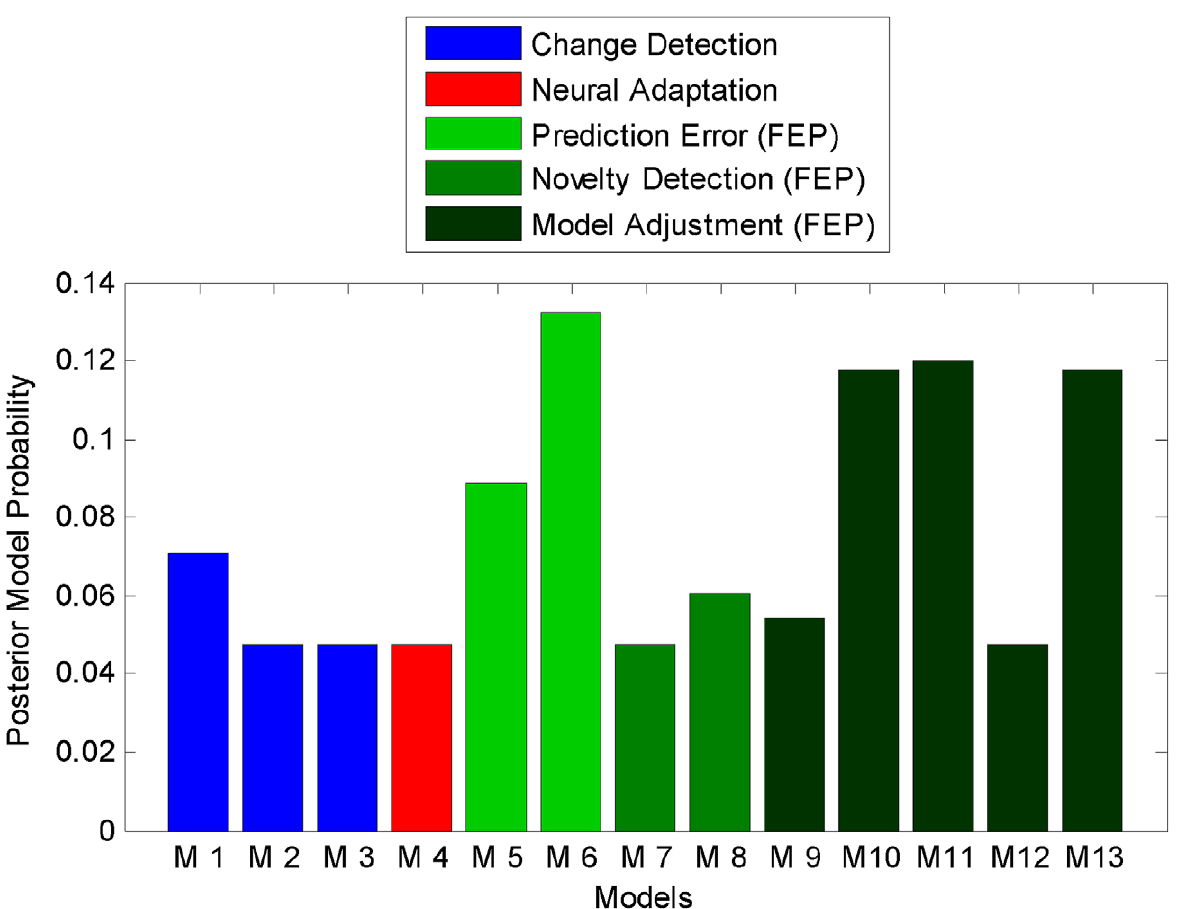
Figure 4. Posterior probabilities of the 13 MMN models. The 13 MMN models were compared by their posterior probability given the trial- wise MMN amplitudes of all eight subjects. These posterior probabilities were computed by random effects Bayesian model selection at the group level. The bars are coloured according to the theory instantiated by each model. The model explaining trial-wise MMN amplitudes by precision weighted prediction errors on the unobservable tone category ( M 6 ) had the highest posterior probability ( P( M 6 D Y ) ~ 0 : 13 ). It is closely followed by three almost equally probable ‘‘model adjustment’’ models ( P ( M 10 D Y ), P ( M 11 D Y ), P ( M 13 D Y ) & 0 : 12 ), and the model explaining trial-wise MMN amplitudes by prediction errors on the observed log-frequency ( P ( M 5 D Y ) ~ 0 : 09 ).